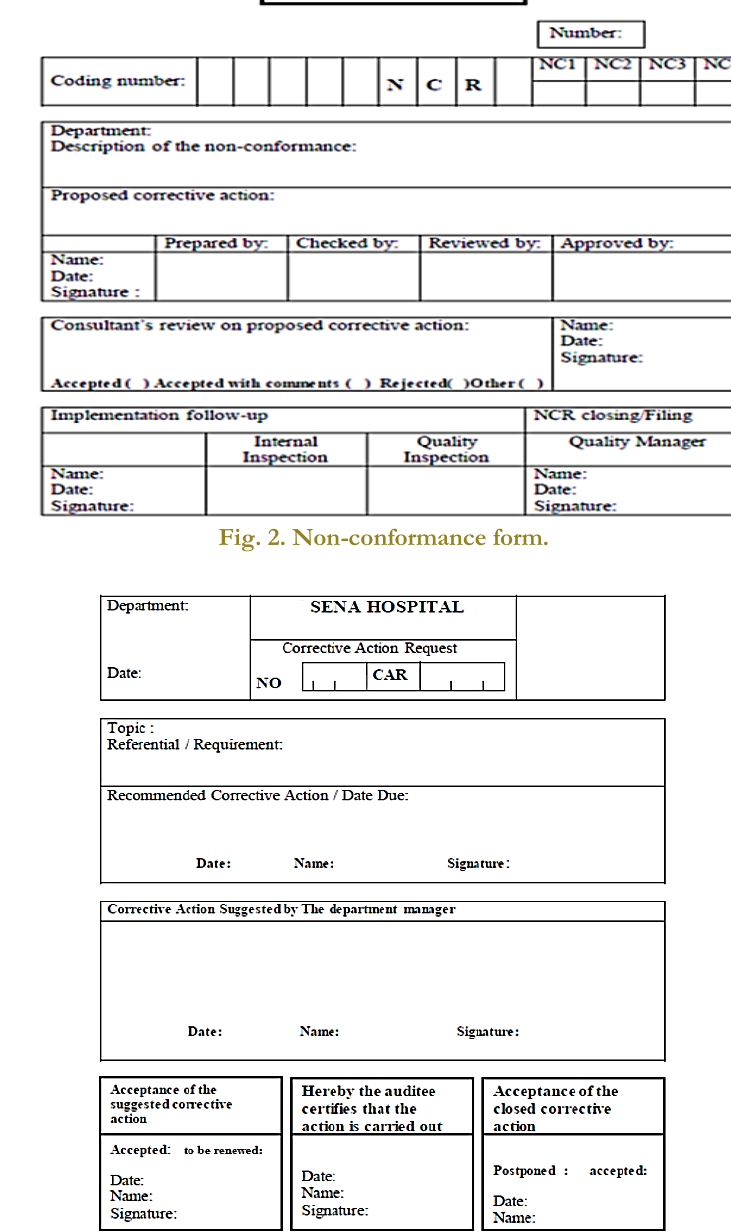
Fig. 3. Corrective and preventive action